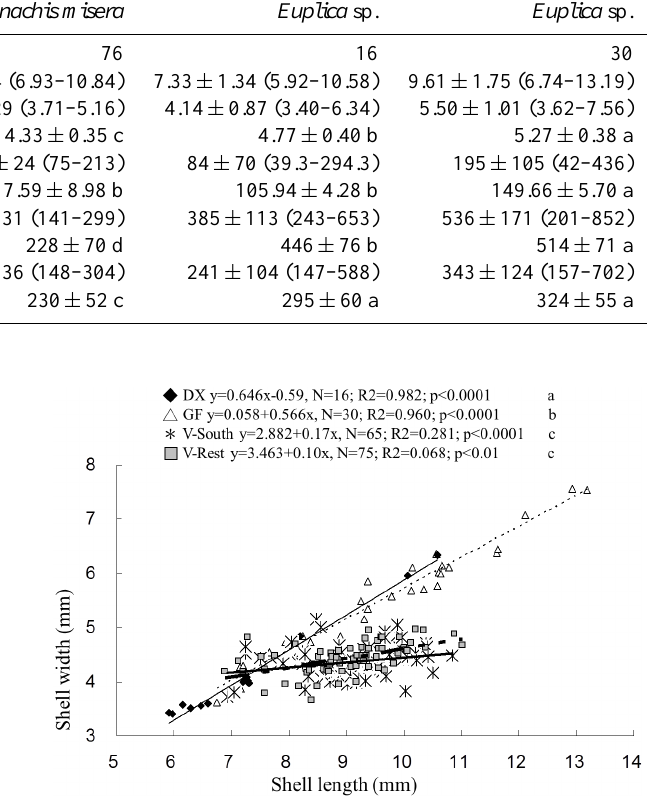
Table 3. Shell traits of Anachis misera around the vent off Kueishan Islet and Euplica sp. from non-vent control sites of Da-xi and Geng- fang. Data are shown as mean ± SD (range of parameter): shell length; SW: shell width; TW: total weight; T1: thickness of body whorl; T2: thickness of penultimate whorl. Least square (LS) means that differ significantly from each other are indicated by different letters. Site V-South V-Rest Da-xi (DX) Geng-fang (GF) Snail sp. Anachis misera Anachis misera Euplica sp. Euplica sp.